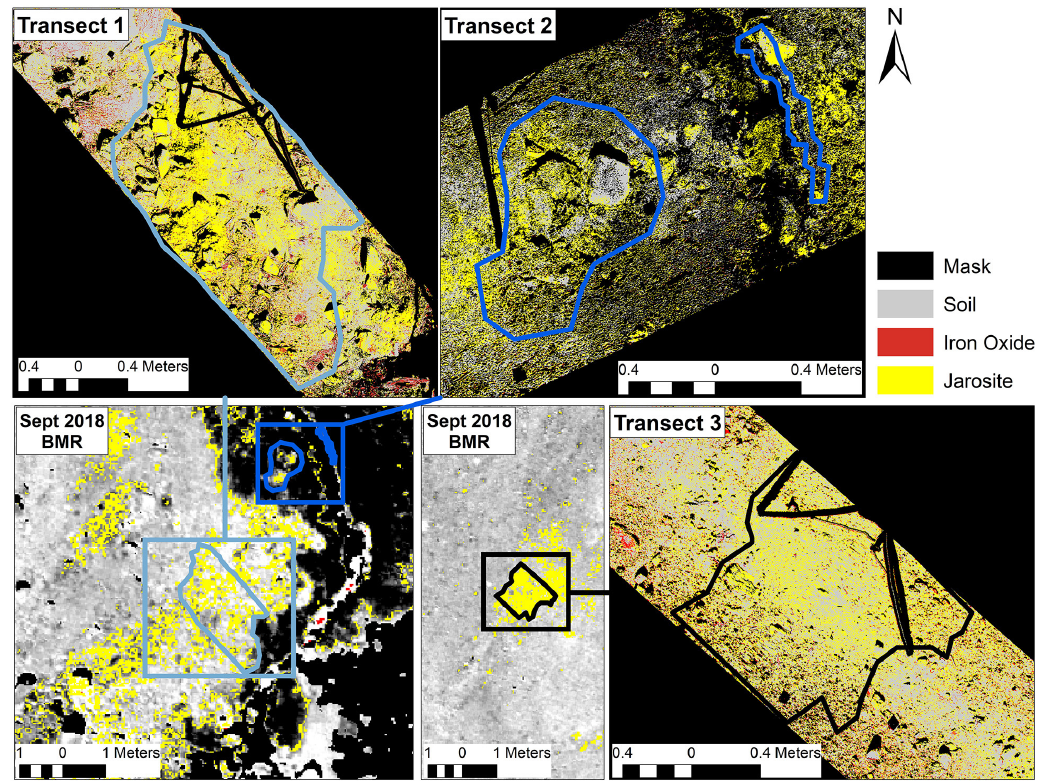
Figure 9. Validation of jarosite in the September 2018 Band Math Ratio classification in Transects 1–3. Jarosite is outlined in black on Transect 3, in dark blue on Transect 2, and in light blue on Transect 1. Each transect location and mapped jarosite area is highlighted on the corresponding September 2018 band math ratio map as called out by color bars linking the band math ratio image to the hyperspectral